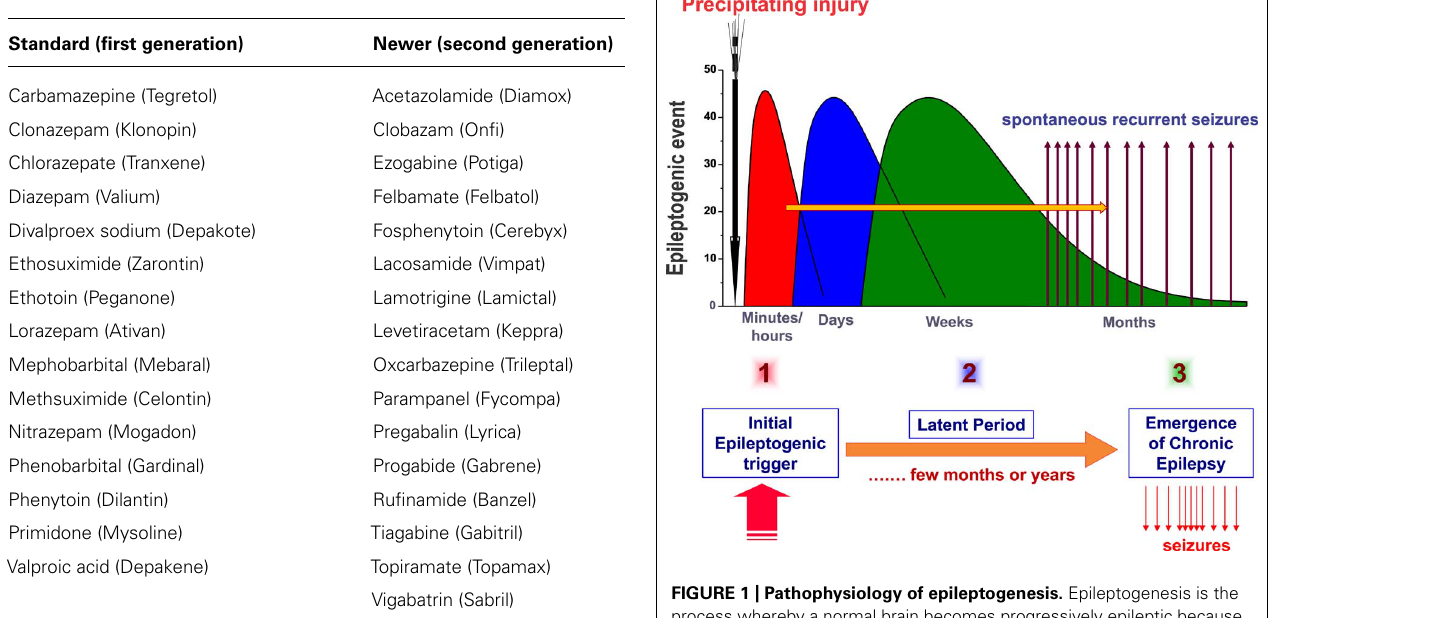
Table 1 | List of current antiepileptic drugs.